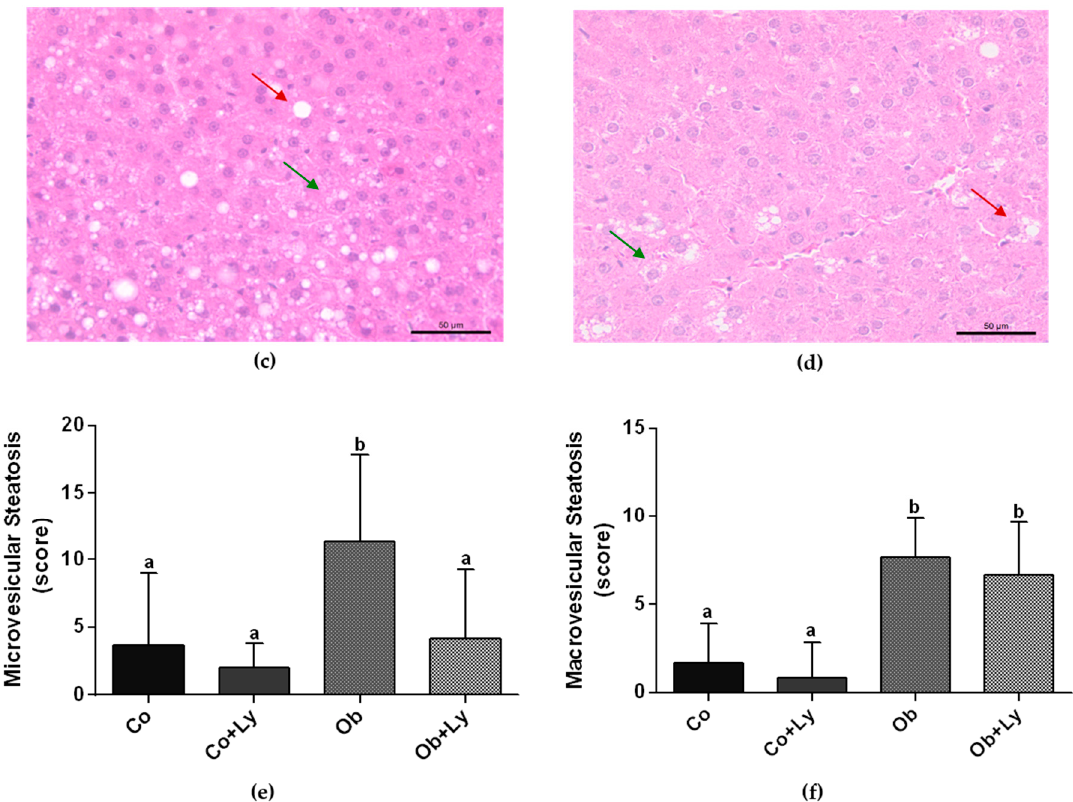
Figure 2. Determination of the hepatic steatosis by hepatic tissue histology stained with haematoxylin and eosin (H&E) ( a ) Illustrative picture (40× magnification) of the control group (Co); ( b ) illustrative picture (40× magnification) of the control group supplemented with lycopene group (Co+Ly); ( c ) illustrative picture (40× magnification) of the obese group (Ob); ( d ) illustrative picture (40× magnification) of the obese group supplemented with lycopene (Ob+Ly); ( e ) microvesicular steatosis (score); ( f ) macrovesicular steatosis (score). Presence of macro (red arrows) and microvesicular (green arrow) steatosis in obese groups. Data expressed in mean ± standard deviation. Comparison by Poasson distribution followed by the post-hoc test Wald multi-comparison. Different letters correspond to the significant statistical difference ( p < 0.05); n = 6 animals/group.